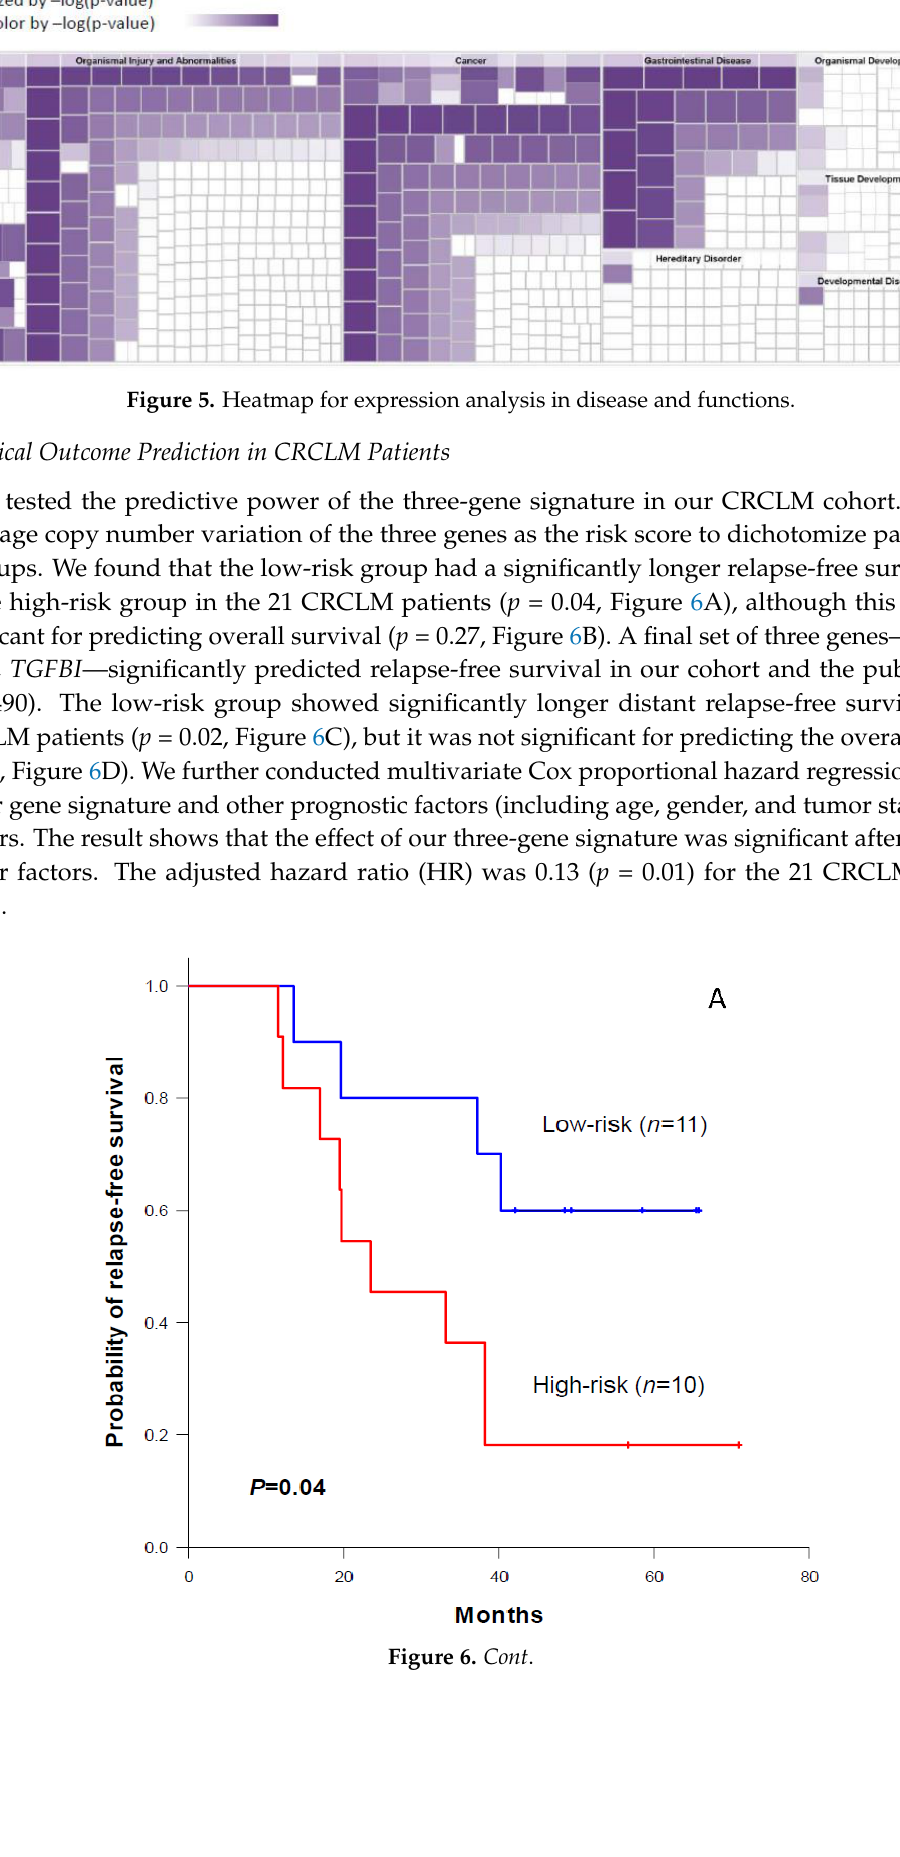
Table 2. Biological functions associated with CRCLM.